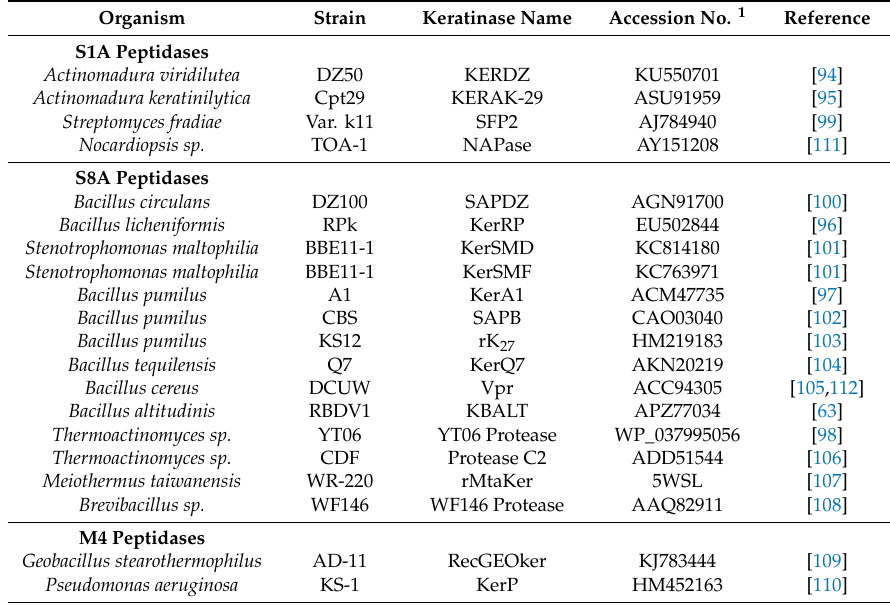
Table 3. Keratinolytic microorganisms and their keratinases from the S1, S8 and M4 keratinases selected for this